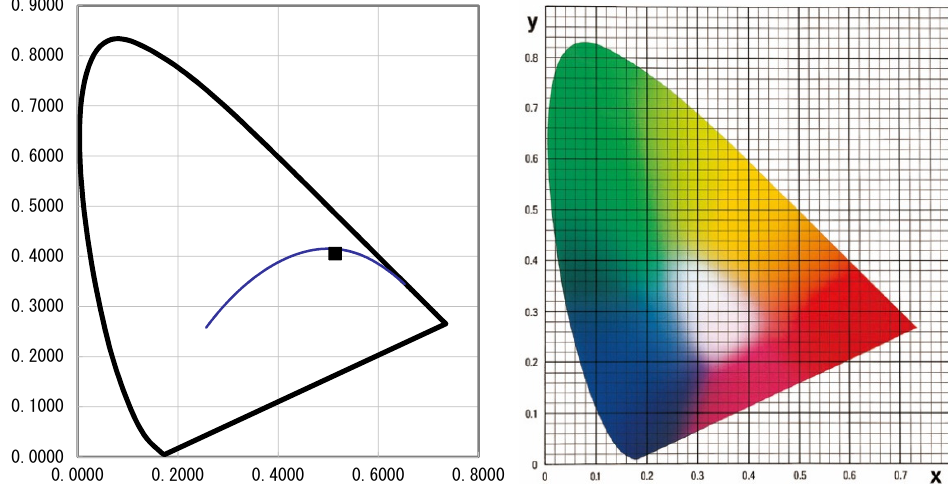
Figure 9. The x-y color temperature of one measurement in the CIE chromaticity space.